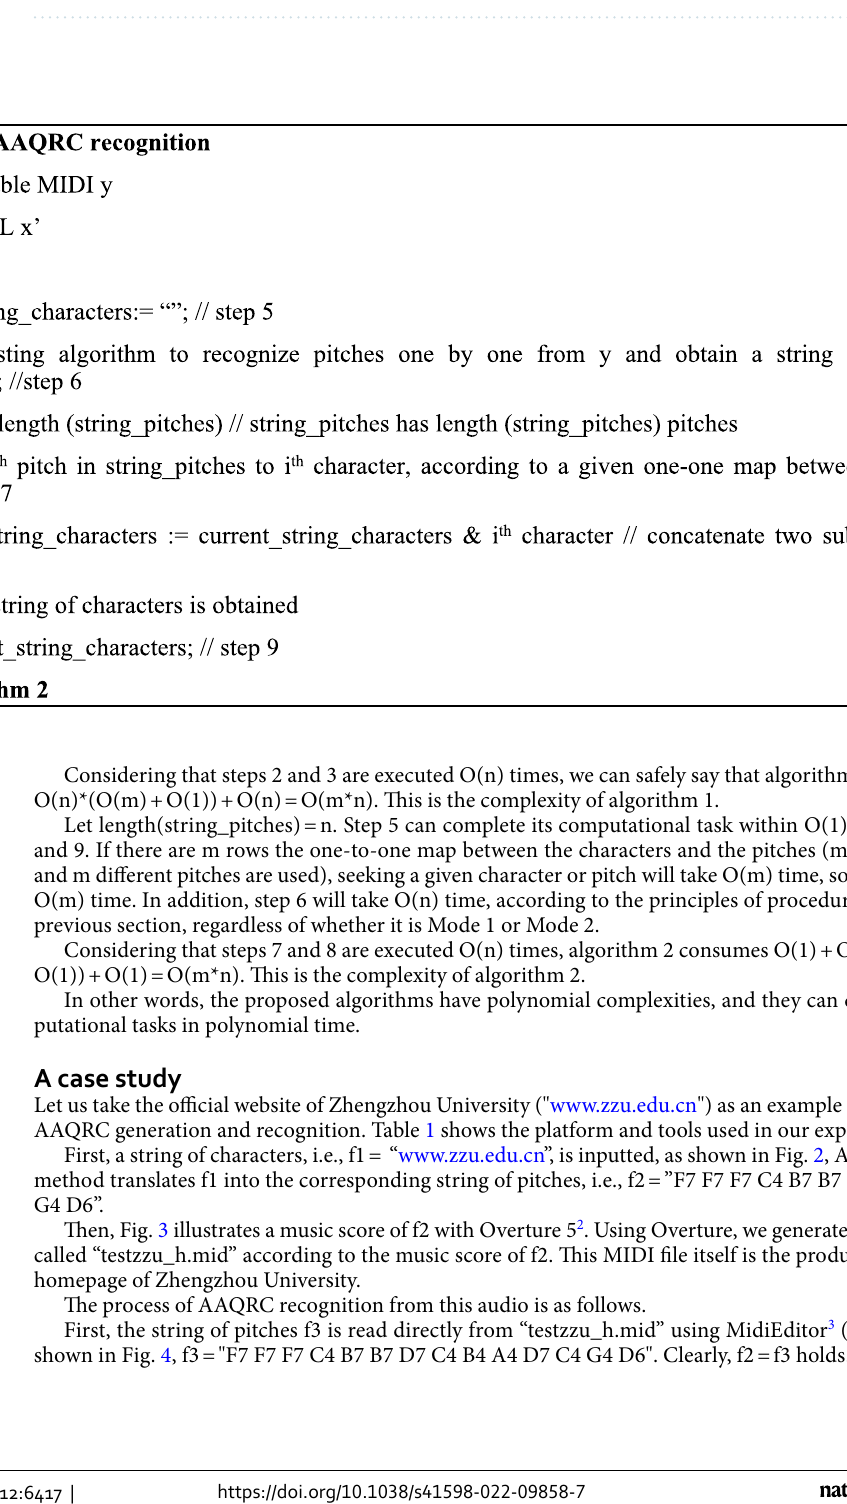
Table 1. The platform and tools